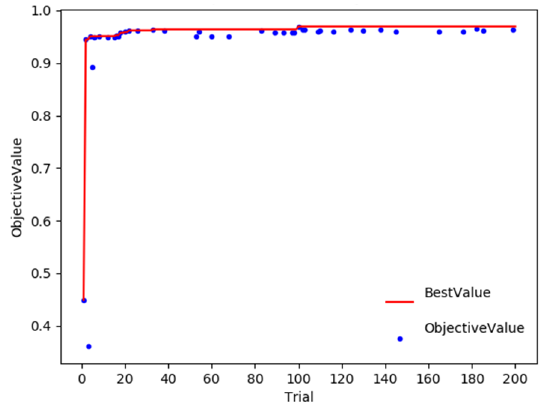
Figure 7. The Bayesian optimization process for the IRBOA model.